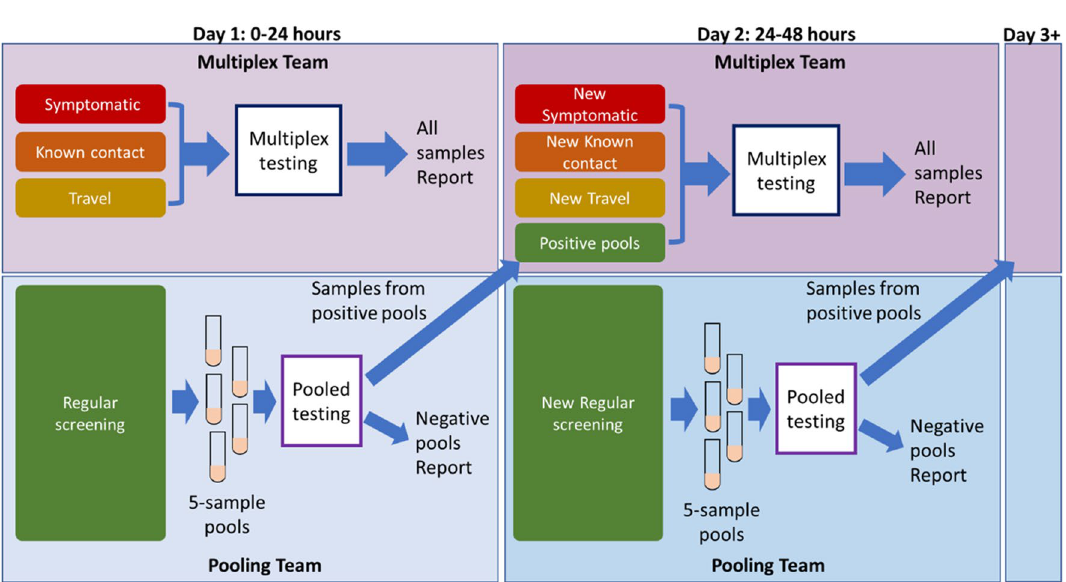
Figure 6. Proposed efficient hybrid testing design using two teams to perform both multiplex testing and pooled testing simultaneously. Day 1 denotes the first day of any testing run, for example a Monday or a week. To maintain ~ 24 time to results, all higher risk samples such as symptomatic, known prior contact with a positive individual and recent travel would be run using the multiplex testing. Regular screening would be run by a second team using the 5-sample pooling method. Negative samples from the screening population would be reported the same day. Samples from the positive pools would be set aside and run with the Day 2 multiplex samples. In this way, all samples would report out in ~ 48 h and all high-risk samples would report out in ~ 24 h from